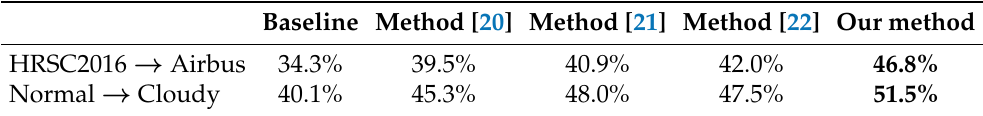
Table 6. We perform the adaption experiments between real remote sensing data and synthetic remote sensing data, respectively. Specifically, we use the HRSC2016 dataset as the source domain for which images and their bounding box annotations are provided, and the Airbus dataset as the target domain for which only unlabeled images are available. All images from the source domain are used for training, while 30% of the images from the target domain are reserved to evaluate the performance of the trained model. In the experiment on synthetic data, the Normal dataset is used as the source domain, while the Cloudy dataset is used as the target domain. Table 6. Quantitative comparison results on the unsupervised domain adaption